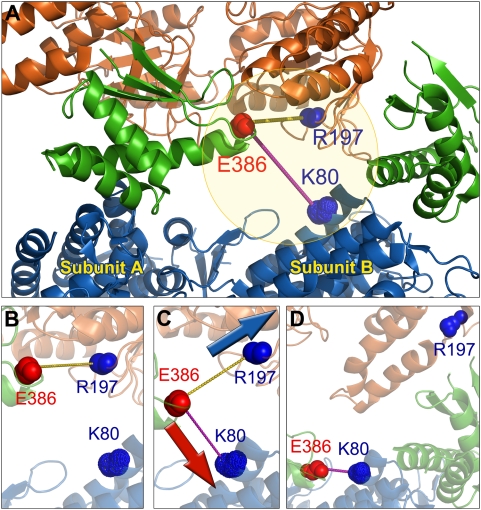
The cis ring inter-subunit interactions during
the transition T→R″, based on the intact GroEL
structure calculation.(A) Intersubunit interface near the intermediate domains (green) of
two adjacent subunits in the cis ring. The
backbones are shown in cartoon view and colored by domains: A
(orange), I (green), and E (blue). Backbone atoms of three charged
residues are shown by spheres. Positively and negatively charged
residues are colored blue and red, respectively. (B) The
inter-subunit hydrogen bond, E386-R197, in the T state of the
cis ring (1GR5). (C) During the transition to
state R″/R, residue E386 in the I domain moves towards K80
(blue sphere) in the E domain of the adjacent subunit, while R197 on
the A domain moves away from E386. (D) The final configuration in
the R″ state of the cis ring, represented
by 1GRU. Residue E386 now forms a new hydrogen bond with K80.